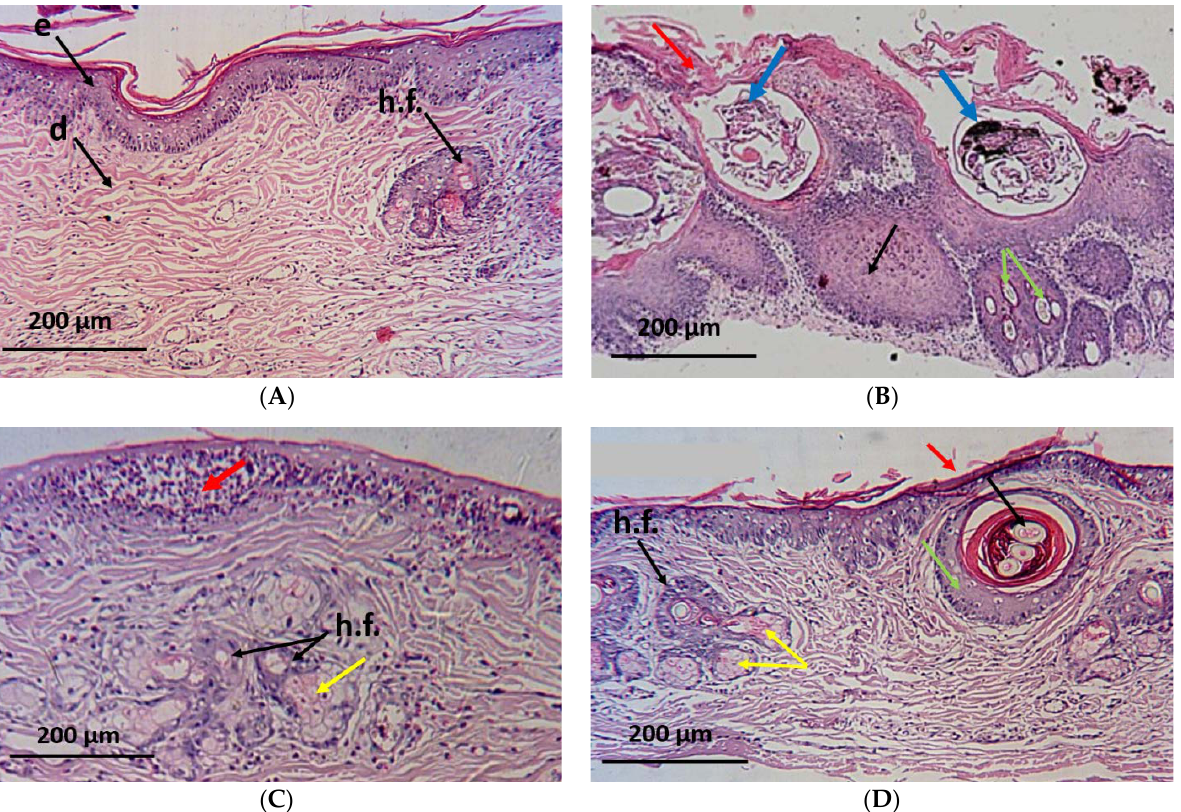
Figure 5. Macroscopical examination of infected rabbits with mange at the end of the experiment. ( A ) control group; ( B ) coconut seed extract group; and ( C ) ivermectin group.